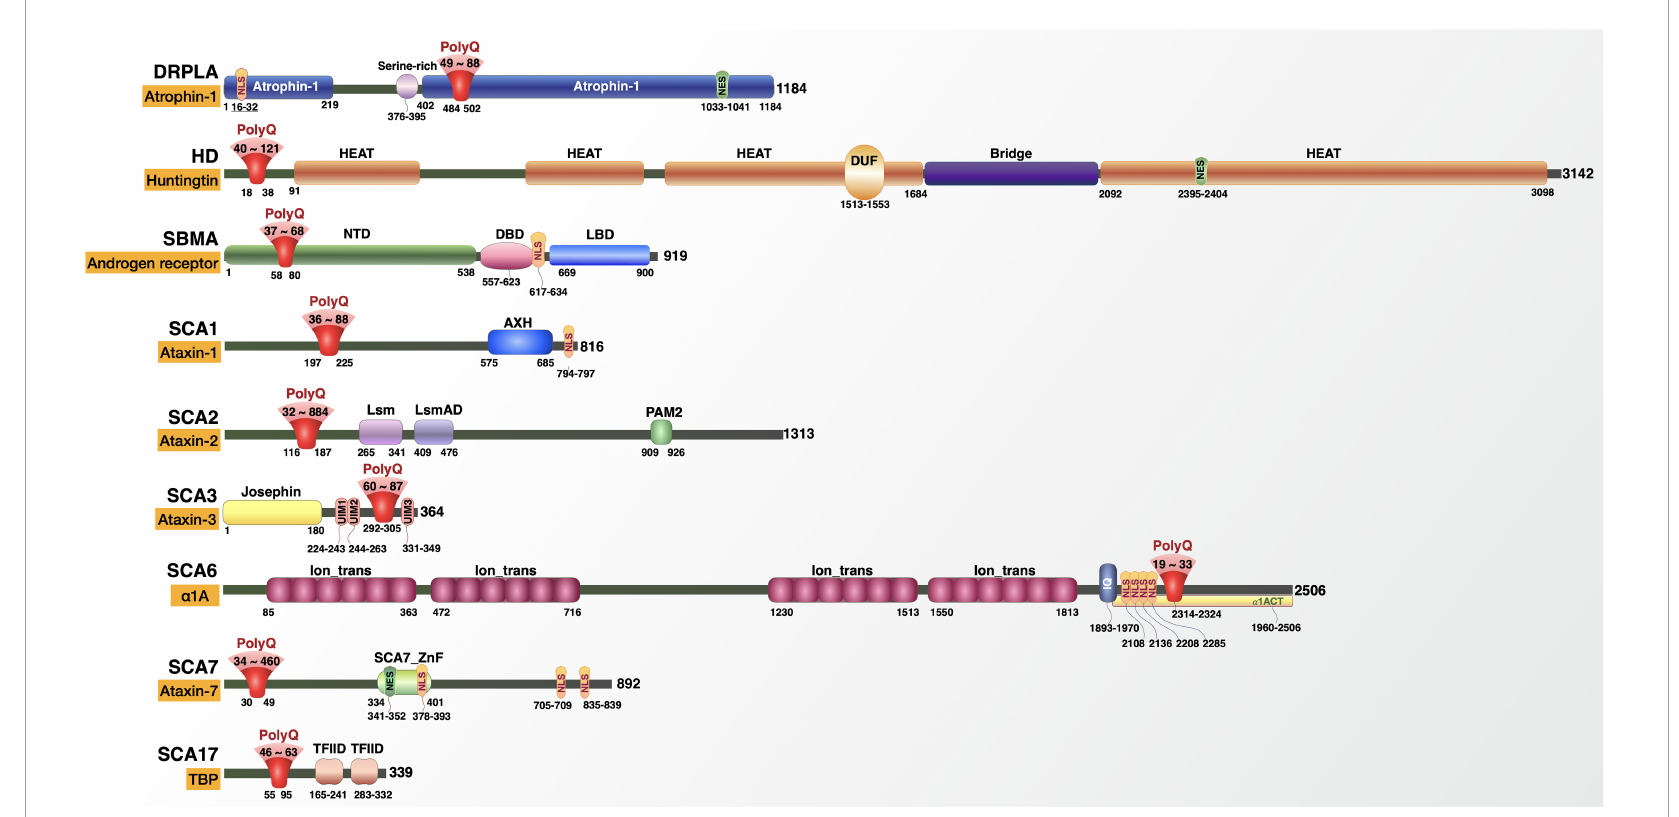
FIGURE1 The polyglutamine disease proteins. Details on each protein’s domains, regions, posttranslational modifications, and interactions are found in Figures 2–10 and in the main